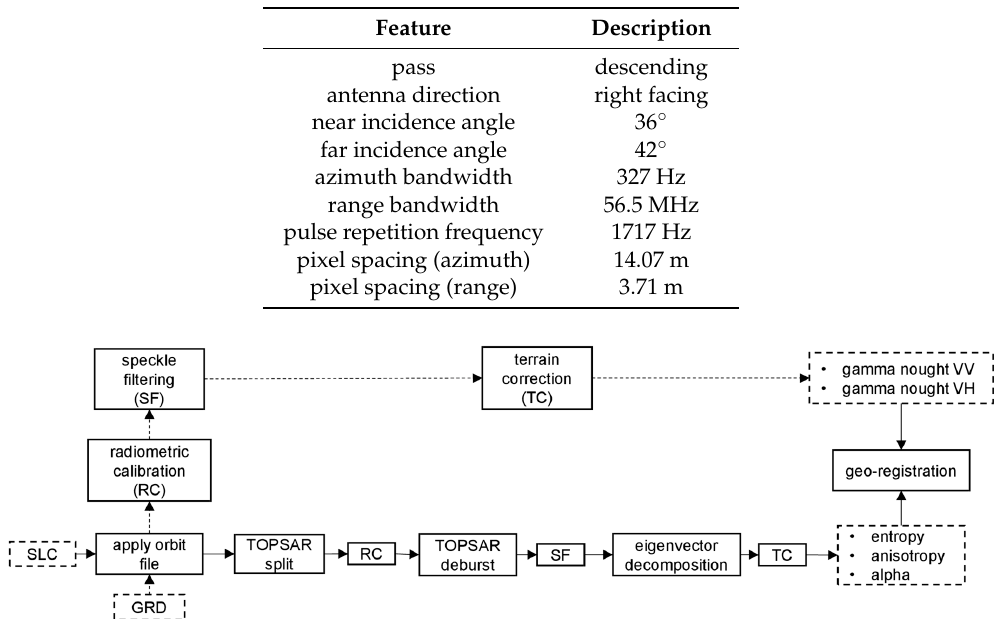
Table 1. Characteristics of the single look complex of the Sentinel-1 image used.